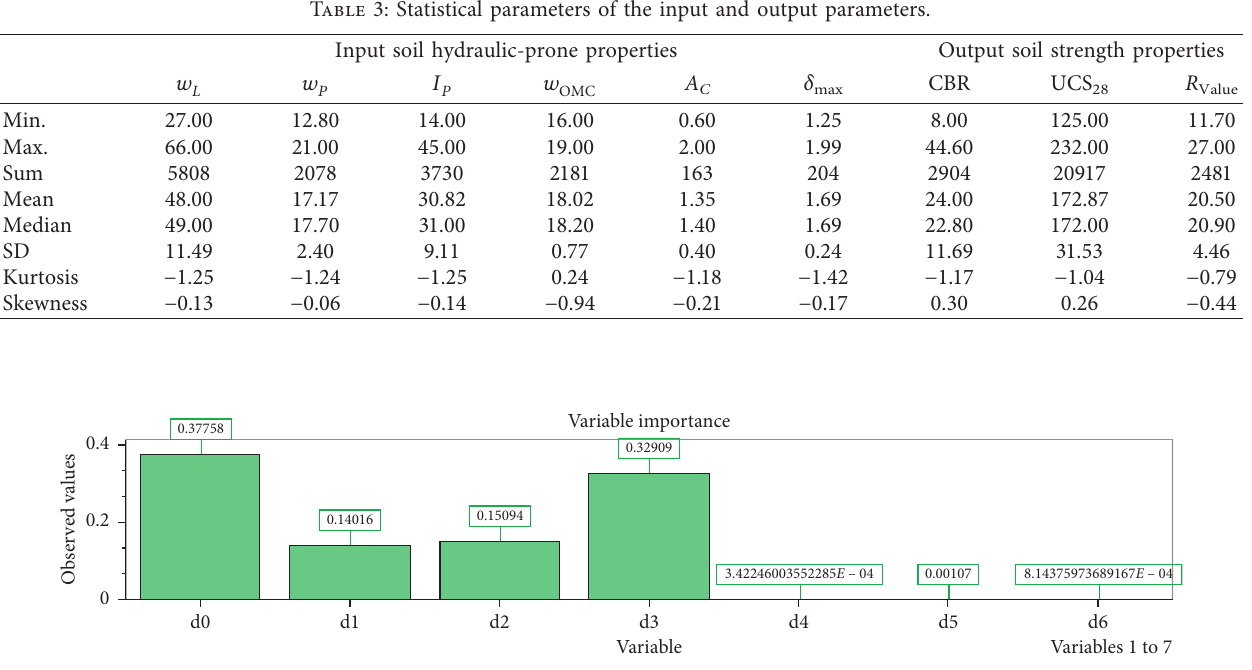
w I w ; (d5) A C ; L ; (d2) P ; (d3) P ; (d4) OMC